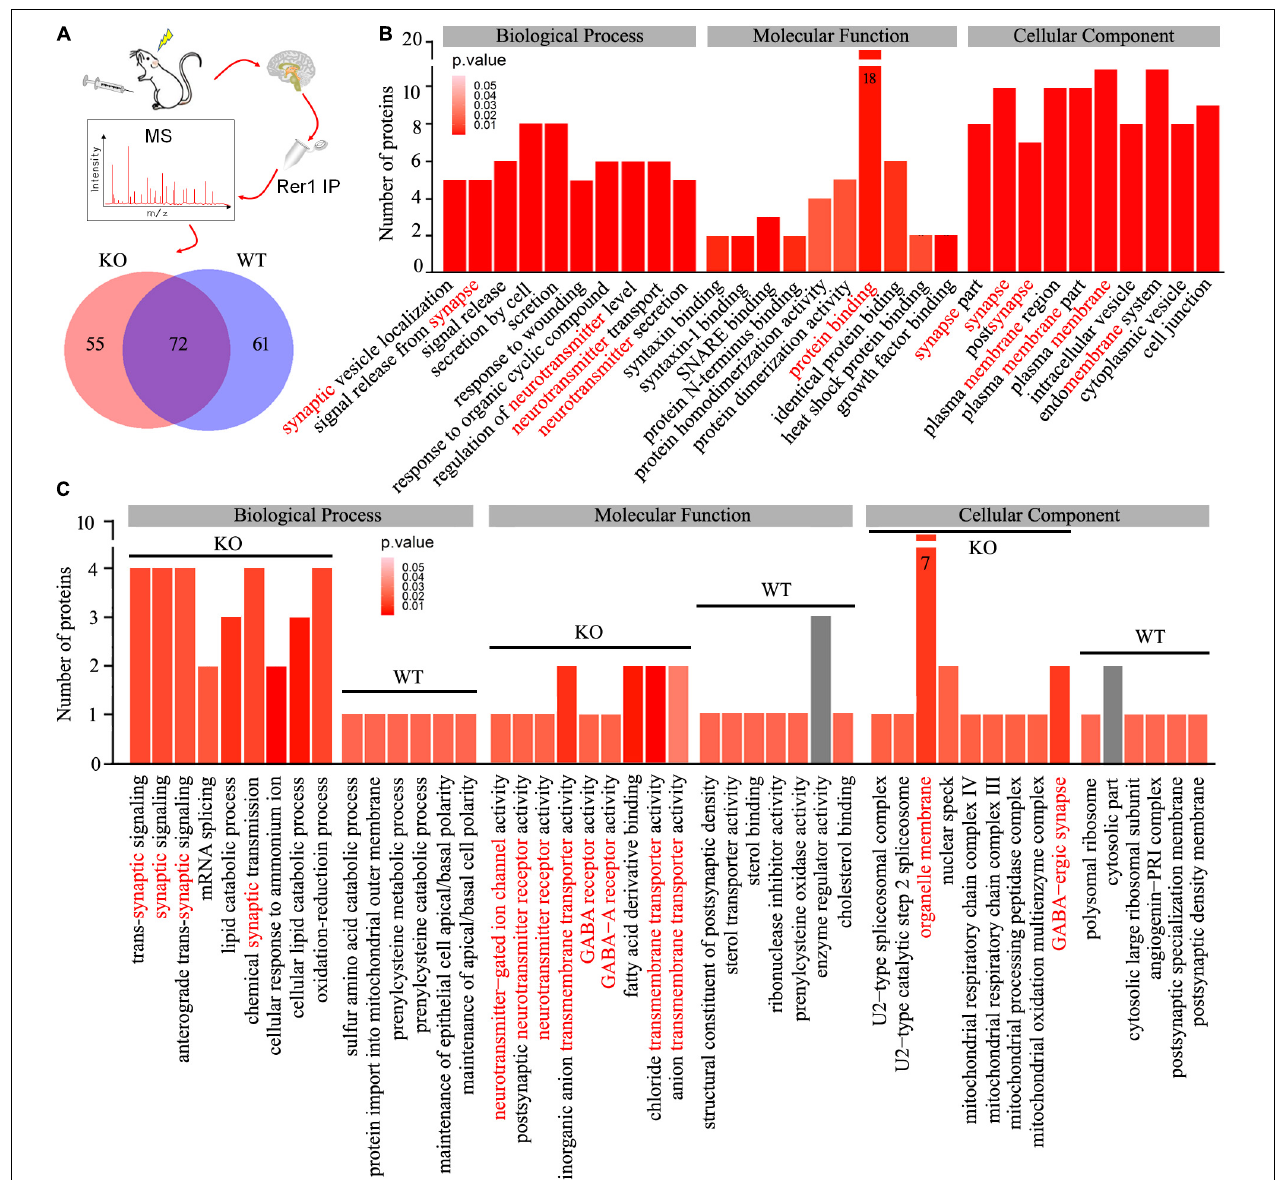
FIGURE 5 | Interactome of Rer1 in mouse hippocampus by immunoprecipitation-mass spectrometry. (A) Nedd4-2 + / − (KO) and wild-type (WT) mice ( n = 4 in each group) were induced into chronic seizures by pentylenetetrazole. The interactive proteins were identified by LC-MS/MS proteomics on Rer1-immunoprecipitated (IP) hippocampal lysates and are shown in a Venn diagram. (B) The top 10 enrichment terms of Biological Process, Molecular Function, and Cellular Component in the Gene Ontology (GO) analyses on the overlapped 72 proteins. (C) Comparison of the enrichment terms in the GO analyses on the differential Rer1 interactive proteins in KO and WT